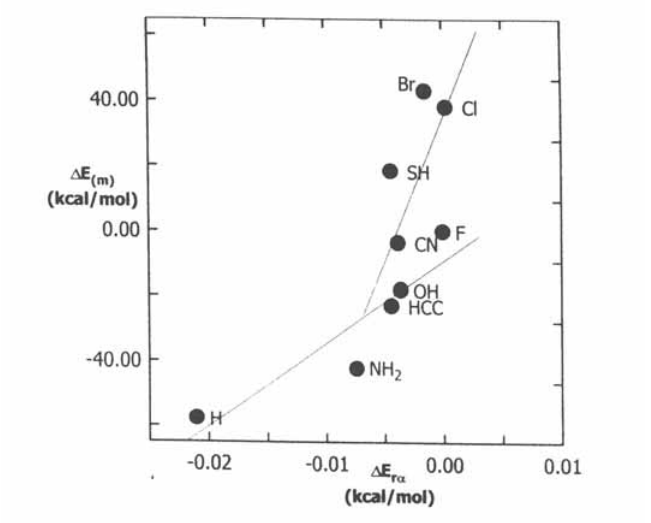
(in kcal mol -1 ) as a function of the reaction energy ∆ E m